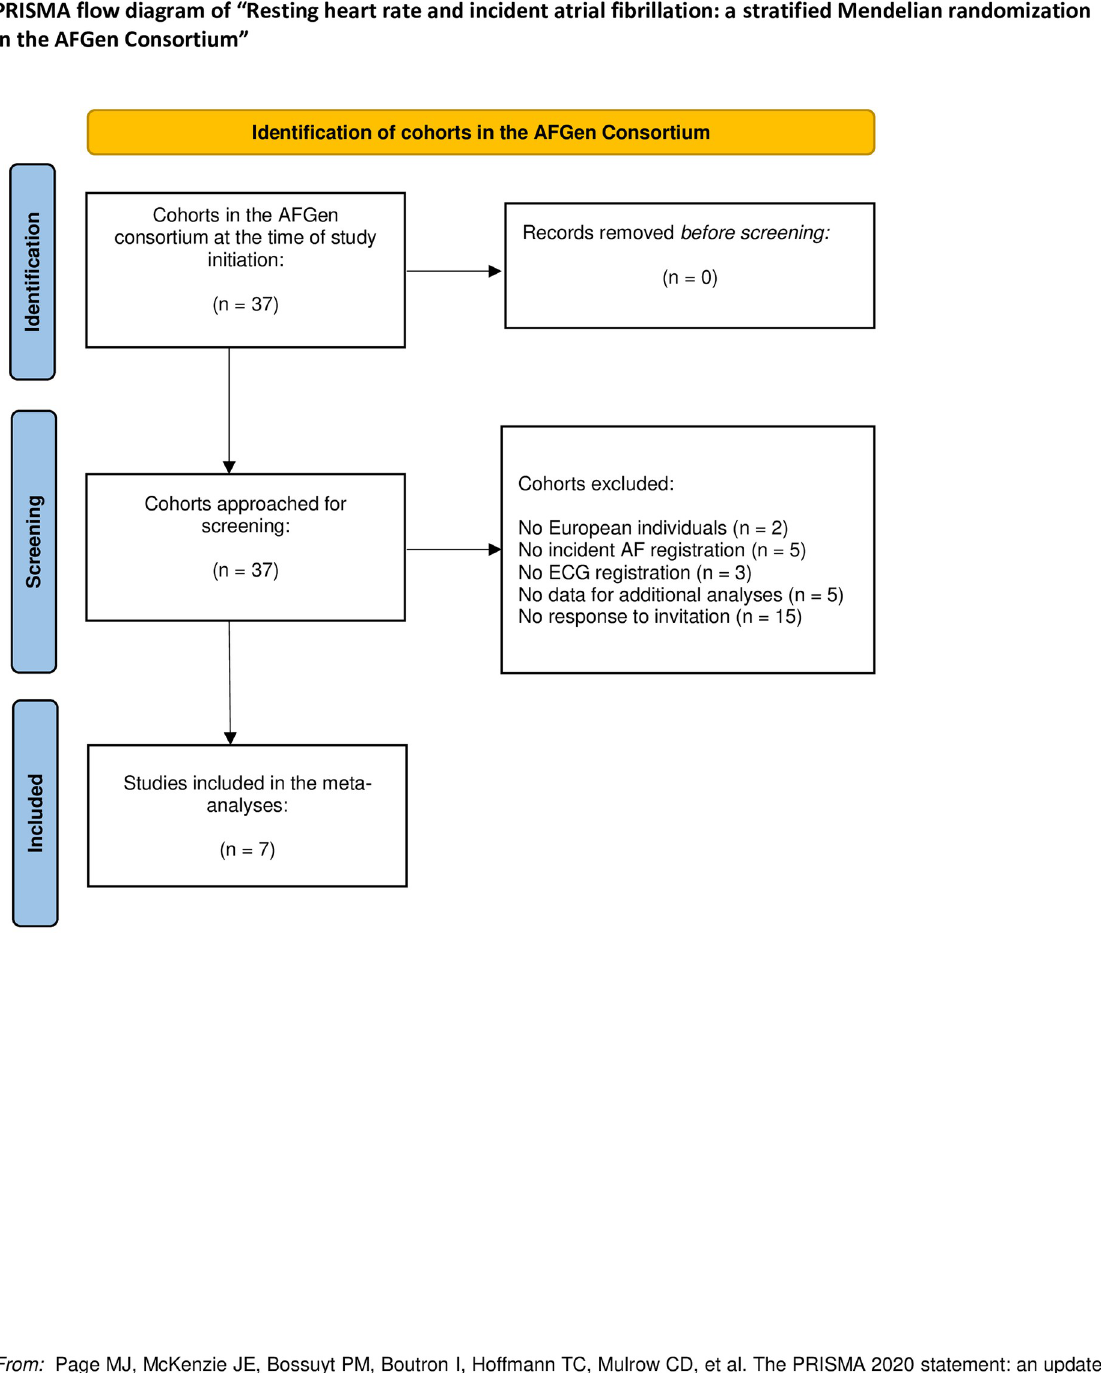
Fig 1. PRISMA flow